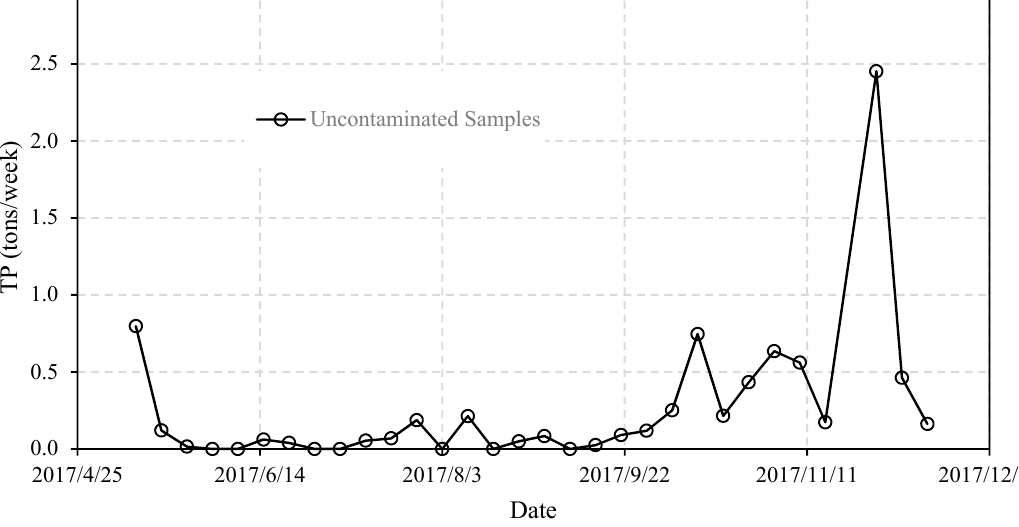
Figure 8. TP lower estimates of weekly loadings (uncontaminated samples).